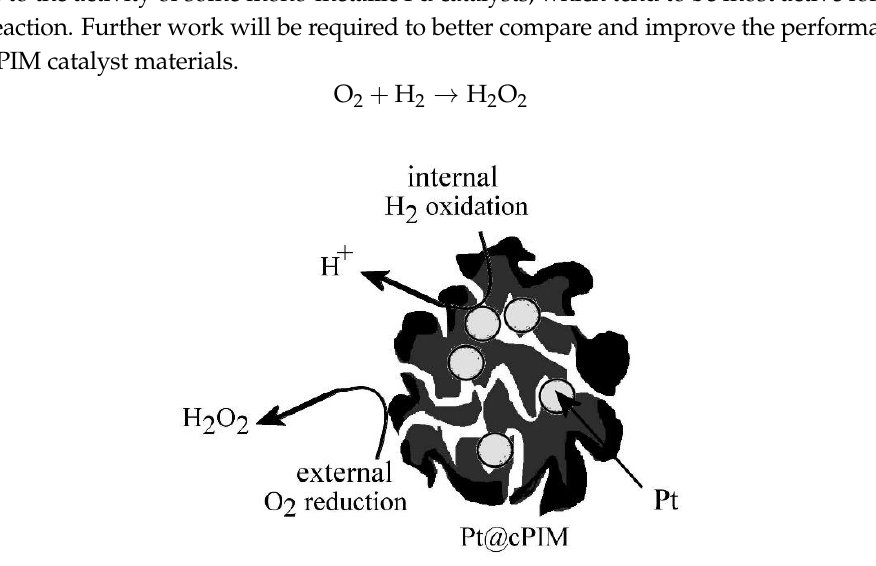
Figure 8. Schematic depiction of the catalytic process involving hydrogen and oxygen to give hydrogen peroxide.